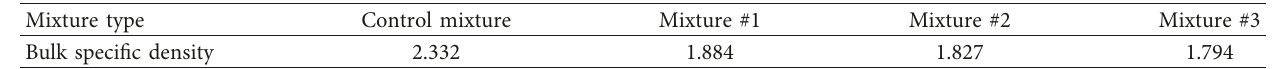
Table 4: Bulk specific densities of different asphalt mixtures.